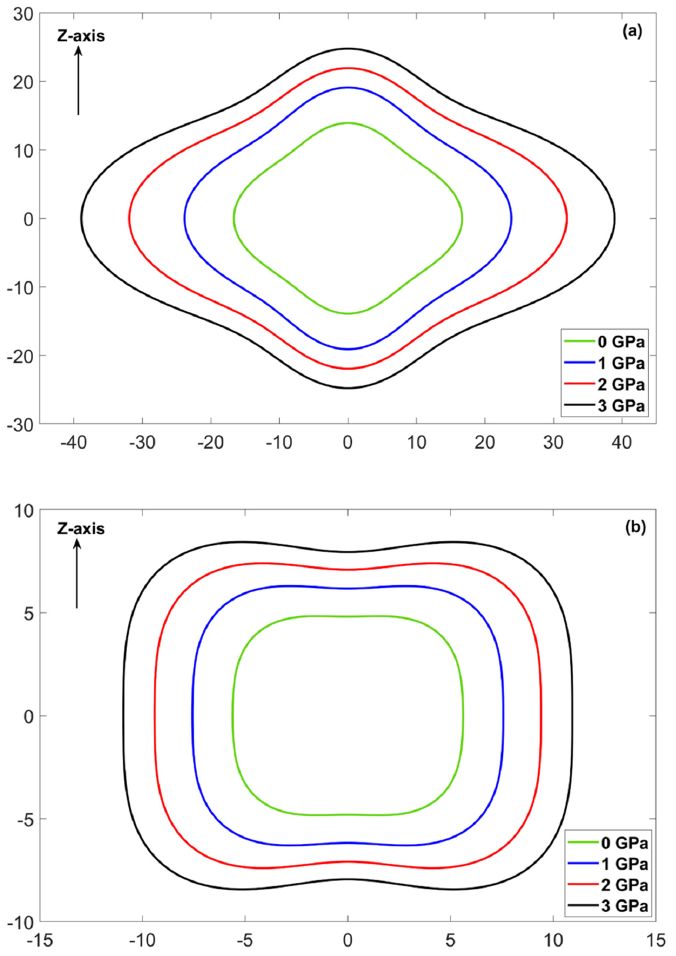
Figure 12. Polar plots of Young’s E ( a ) and shear G ( b ) moduli of CO 2 -NH sH gas hydrate at different pressures and 0 K. Moduli unit is GPa.